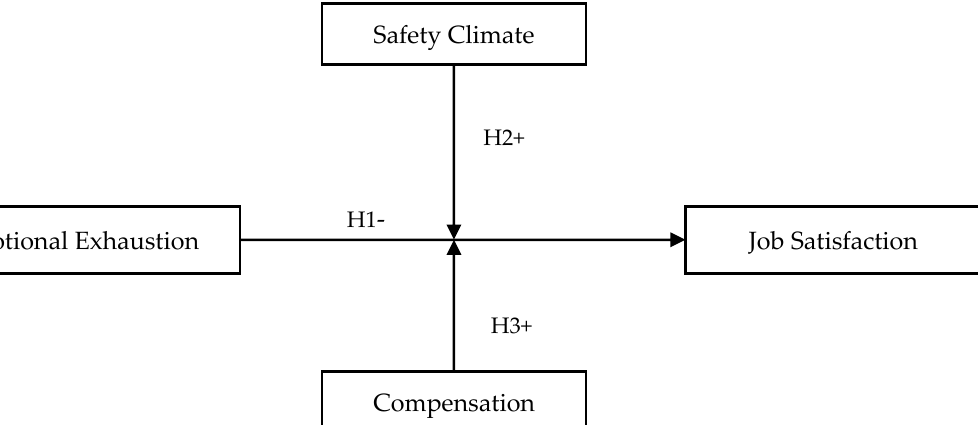
Figure 1. Hypothesized research model.